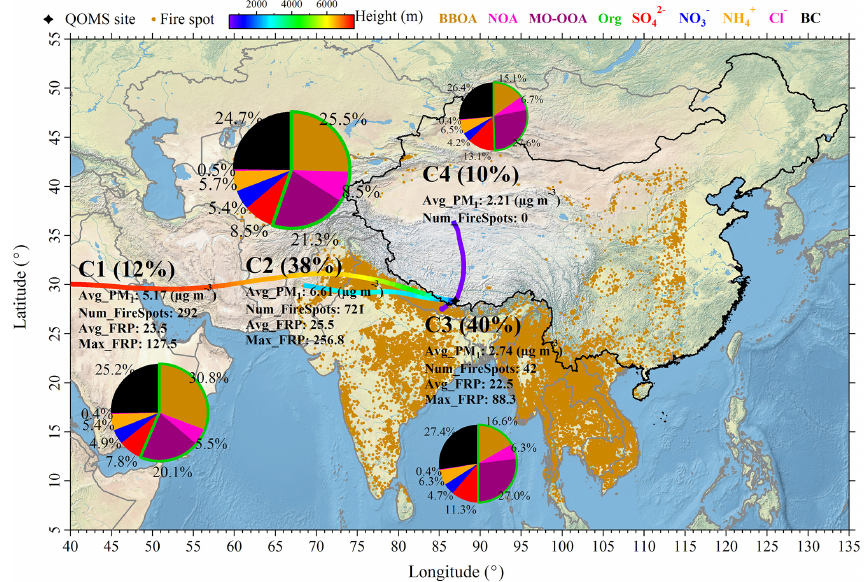
Figure 9. The average back trajectory clusters during the entire study and the corresponding mass contributions of PM 1 species and OA fac- tors to the total PM 1 mass. The areas of each pie chart are scaled by the corresponding average PM 1 mass concentrations. The average PM 1 mass concentrations, number of fire hotspots as well as the average and maximum fire radiative powers (FRP) belonging to each of the clusters during the entire measurement period are also